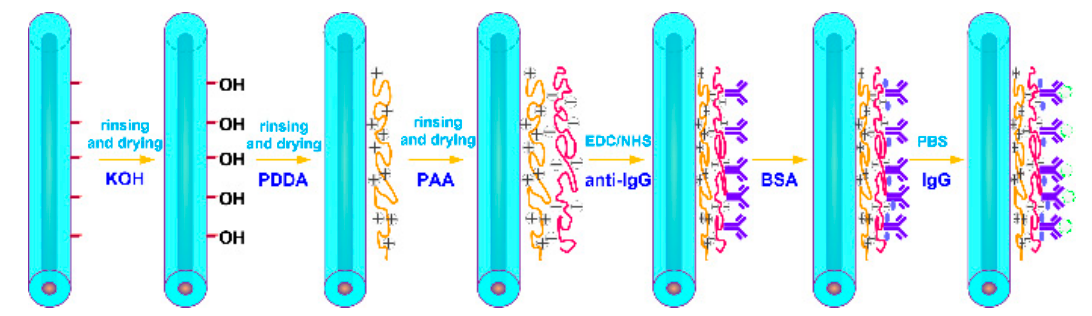
Figure 4. PDDA and PAA modification procedure for IgG immunoassay.